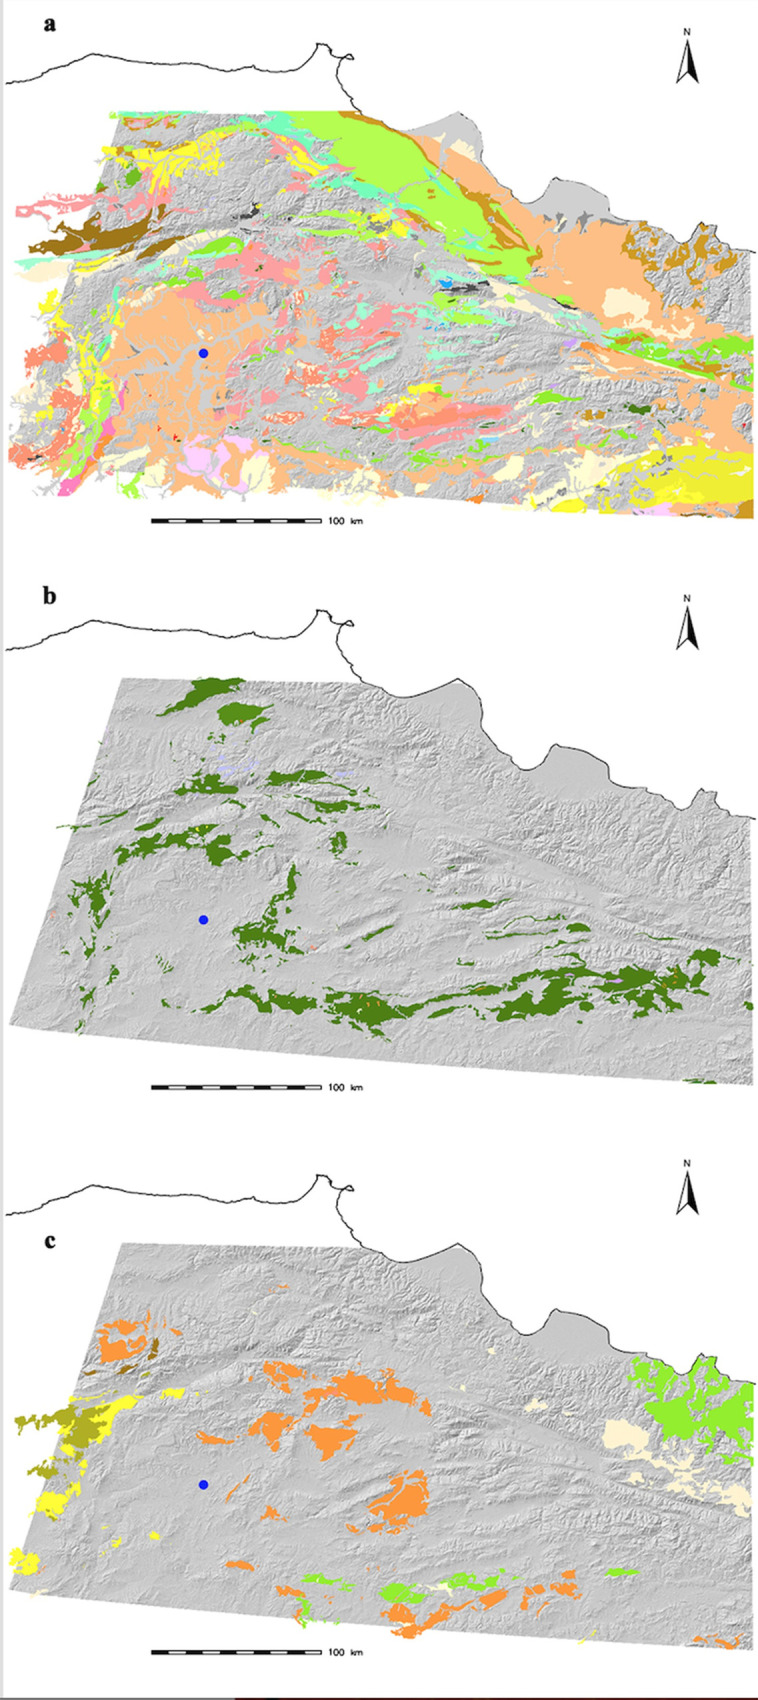
a) Sedimentary; b) Ophiolitic; c) Volcanic rocks in and around the Delice Valley and modern Çorum. Different colors indicate different geological ages. Blue circle indicates the location of Resuloğlu (maps: courtesy of Bülent Arıkan).